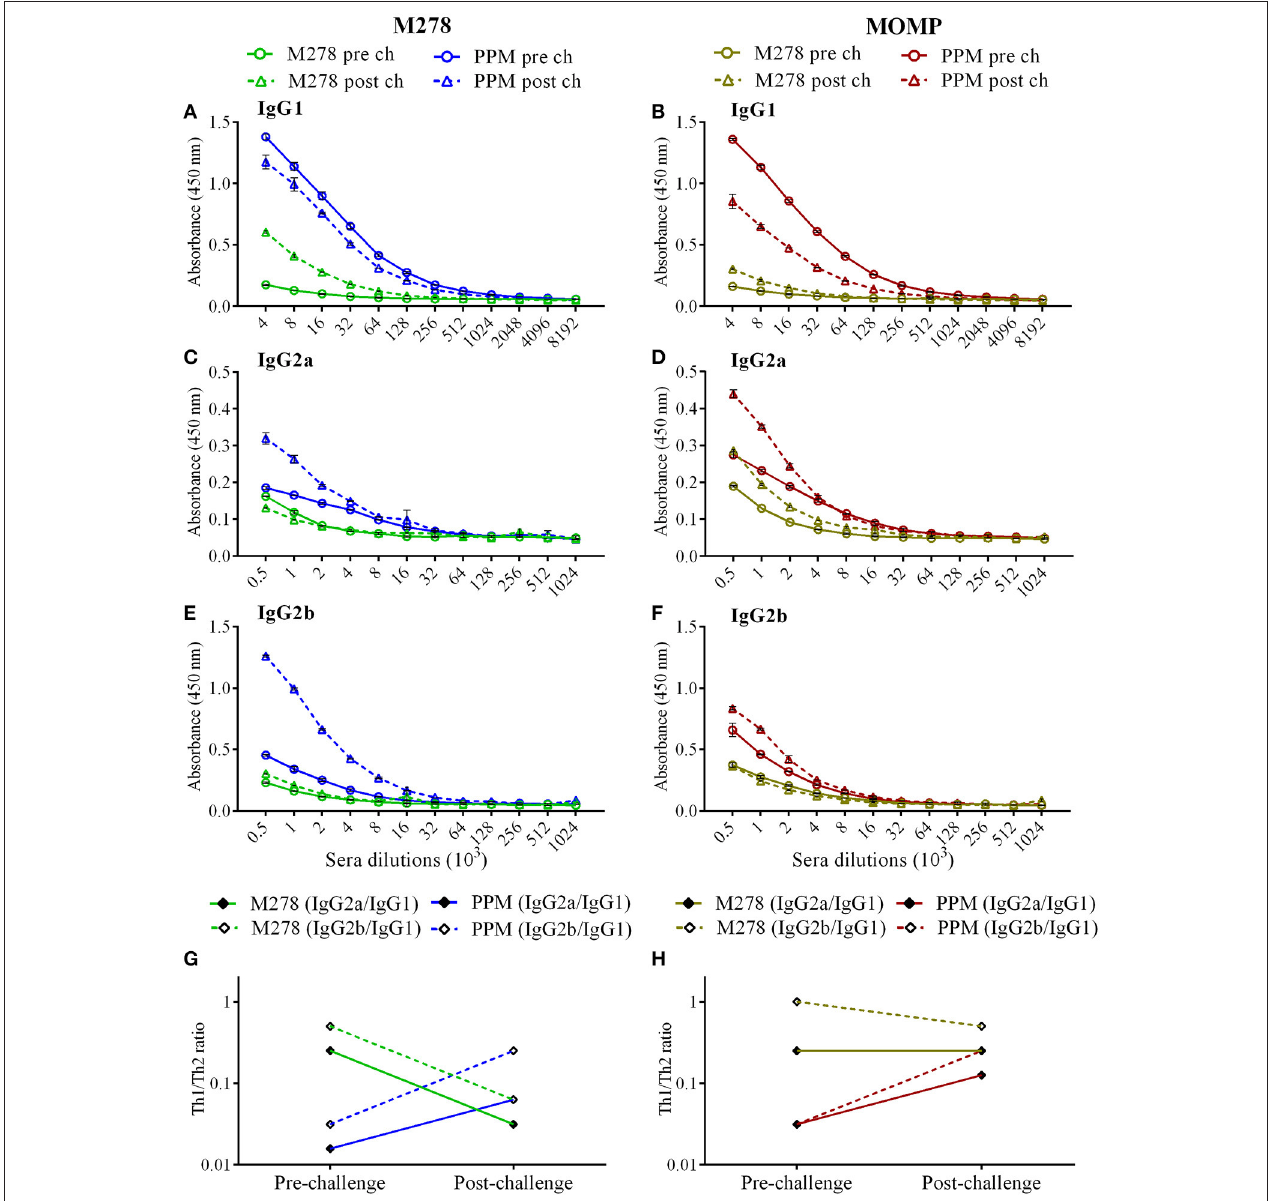
FIGURE 4 | Antigen-specific serum antibodies production in immunized mice. Groups of mice received three subcutaneous immunizations at 2 weeks intervals with either bare M278 or PPM. Three-weeks following the last immunization, each mouse was challenged intravaginally with 1 × 10 5 IFU of C. muridarum. M278-specific IgG1 (A) , IgG2a (C) , IgG2b (E), and MOMP-specific IgG1 (B) , IgG2a (D), and IgG2b (F) antibodies were measured by ELISA in pooled sera 2 weeks after the third immunization (pre-challenge) and 3 weeks after the challenge infection (post-challenge). Sera were diluted at a two-fold serial dilution to determine the end-point antibody isotype titers. M278-specific (G) and MOMP-specific (H) Th1/Th2 (IgG2a/IgG1 and IgG2b/IgG1) antibody ratios were calculated using the endpoint titers. Each data point represents the mean ± standard deviation of duplicate samples and each experiment was repeated at least two times. M278 (bare M278 immunized group); PPM (PLA-PEG-M278 immunized group); pre ch (pre-challenge); post ch (post-challenge).